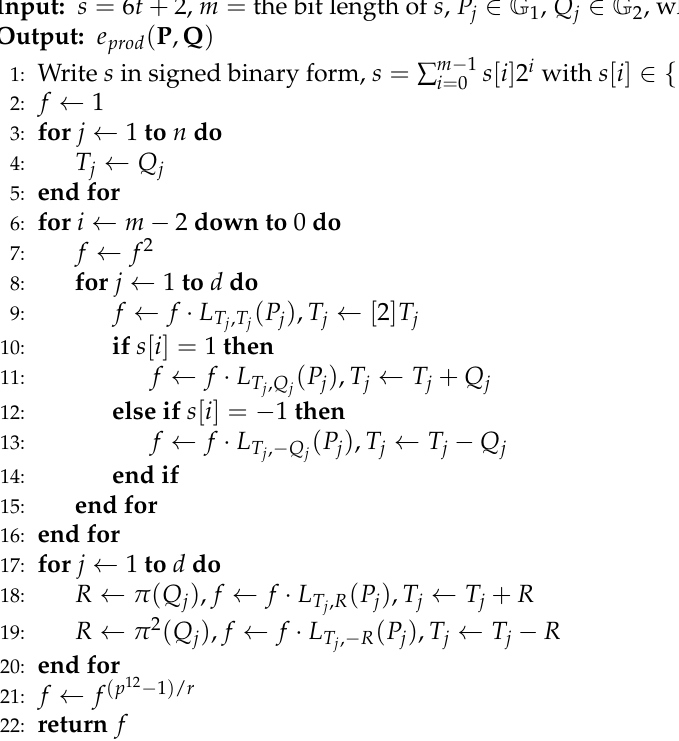
Algorithm 2 Products of optimal Ate pairings on the BN curve (Product method).